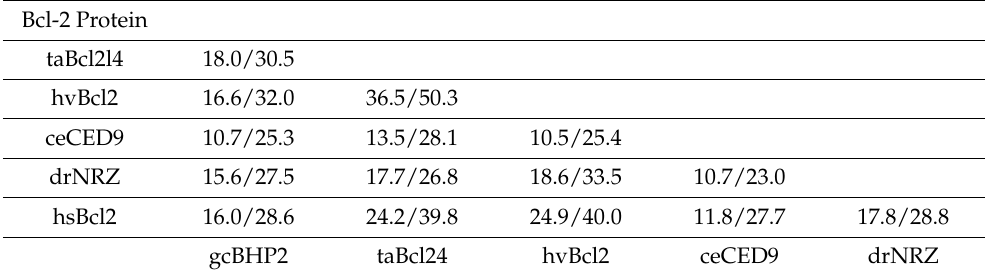
Figure 2. Structural similarity of Bcl-2 proteins derived from early metazoans and bilaterians. The structure of the Bcl-2 fold has been conserved over evolutionary time frames. ( a ) Structurally aligned Bcl-2 proteins. There are relatively minor differences in structure between simple and complex metazoans. Protein data bank (pdb) entries: 5TWA, G. cydonium BHP2 (gcBHP2); 6YLD T adhaerens Bcl-2L4 (taBcl-2); 6WH0 H. vulgaris Bcl-2 (hvBcl2); 1TY4, C. elegans CED-9 (ceCED-9); 6FBX D. rerio NRZ (drNRZ); 2XA0 H. Sapiens Bcl-2 (hsBcl-2). The BH3 ligand of these complexes was removed. Helices are colored: α 1 (blue), α 2 (deep pink), α 3 (brown), α 4 (salmon), α 5 (green), α 6 (purple), α 7 (cyan), α 8 (orange). Helices are indicated in color according to the alignment. The N and C termini are indicated on gcBHP2 ( b ) Structure based sequence alignment performed using DALI [38] and the PDB files given in ( a ). The helices are indicated by the colored bars ( c ) Dendrogram depicting the relationship between structures based on the structure-sequence alignment of ( b ). The phylogenetic tree was calculated in MEGA7 using the maximum likelihood method and details are provided in the methods and the percentage of trees in which the associated taxa clustered together is shown next to the branches. Table 1. Sequence identity and similarity analysis of Bcl-2 proteins from representative metazoans from early to late evolution. Sequence identities and similarity determined for the structure se- quences using the sequence manipulation suite [39] reported as percentage identity/similarity.